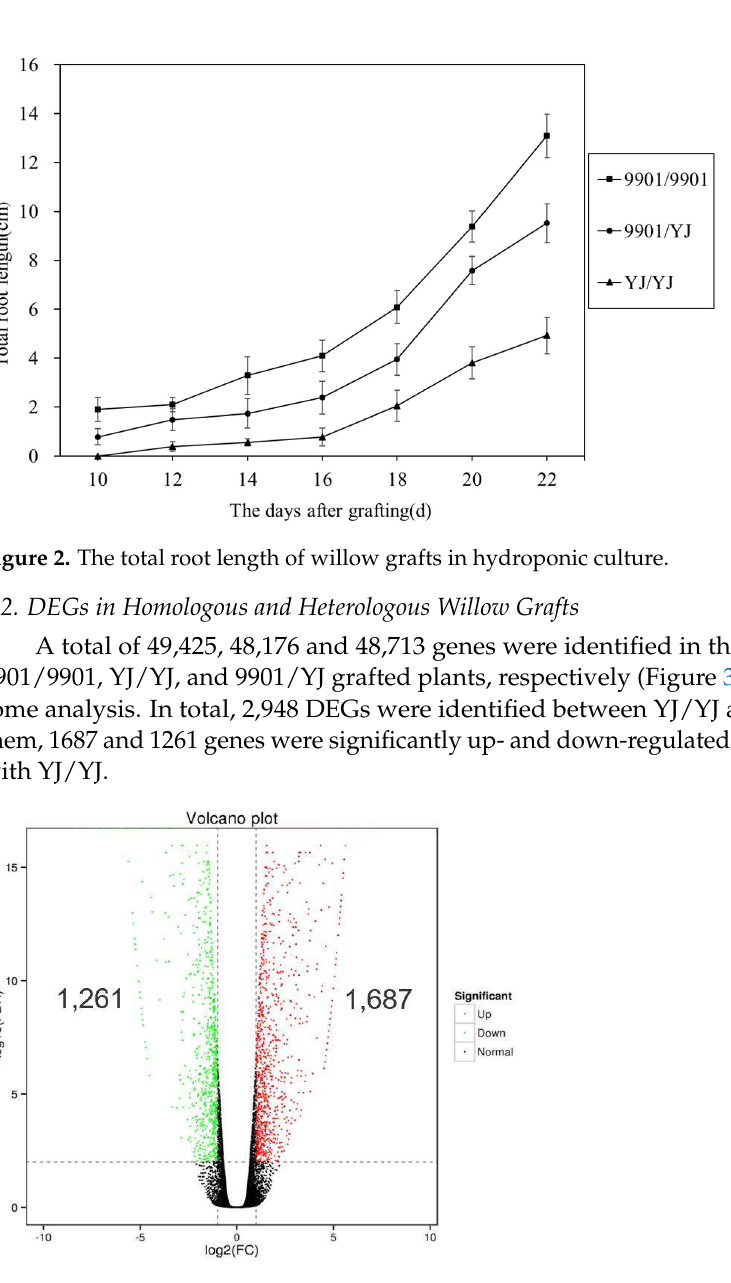
Figure 3. Volcano plot of DEGs in rootstocks of 9901/YJ compared with YJ/YJ.